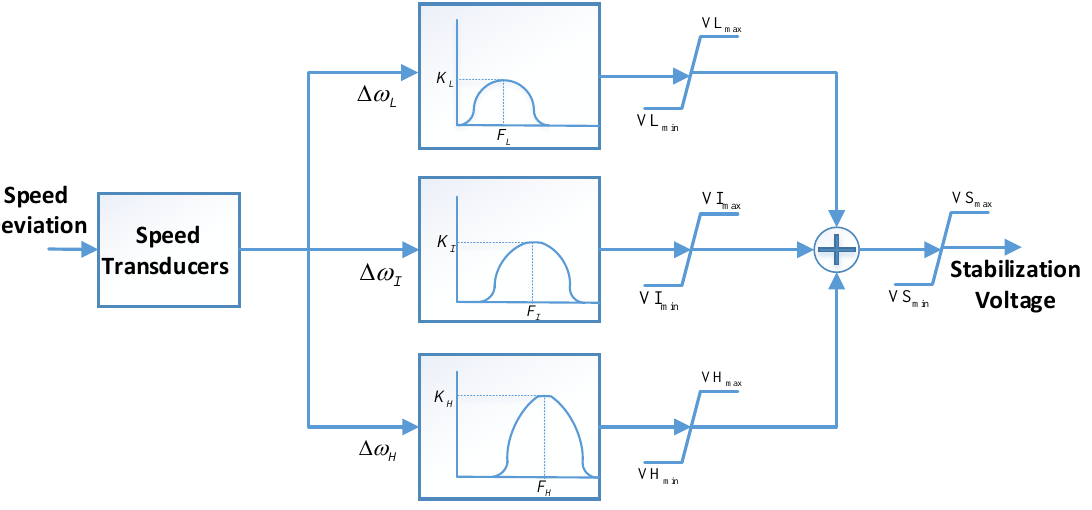
Figure 4. Block diagram representation of the multi-band